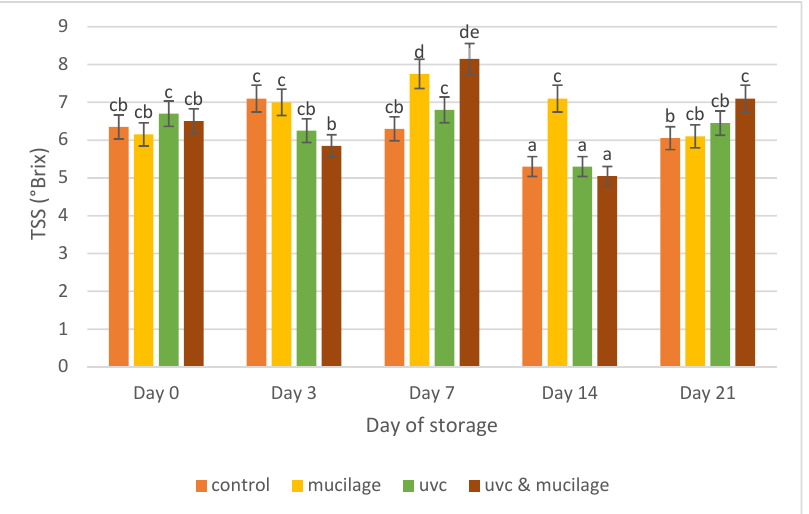
Figure 6. Effect of mucilage coating and UV-C on total soluble solids. Values followed by different letters within the same column are significantly different ( p < 0.05) ( n = 12).